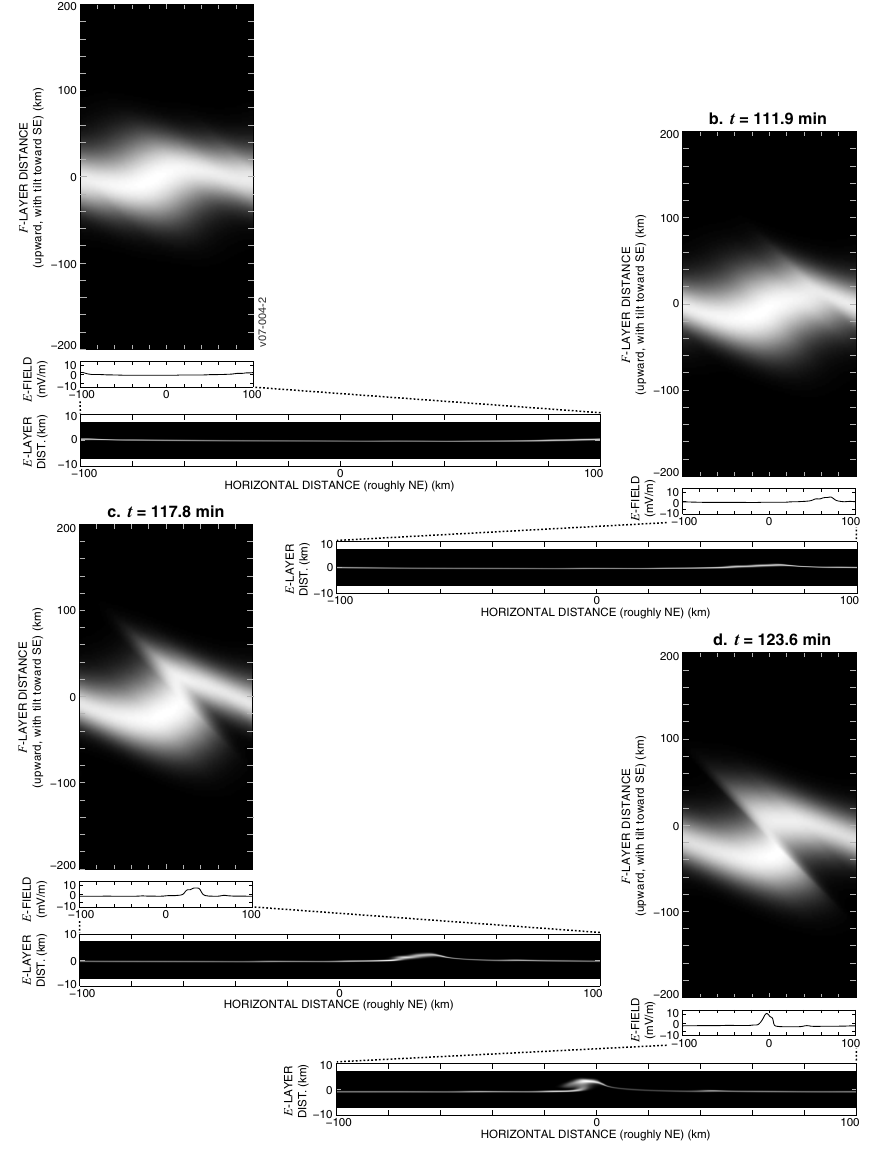
Figure 10: Coupled system evolution under non-resonant condition, with Σ H Σ = 1 . 0, and the E s layer at 105 km altitude. The boundaryconditions are periodic in the horizontal direction. The axes are described in thefirst paragraphs of Section 4, and summarized in Figure 3.